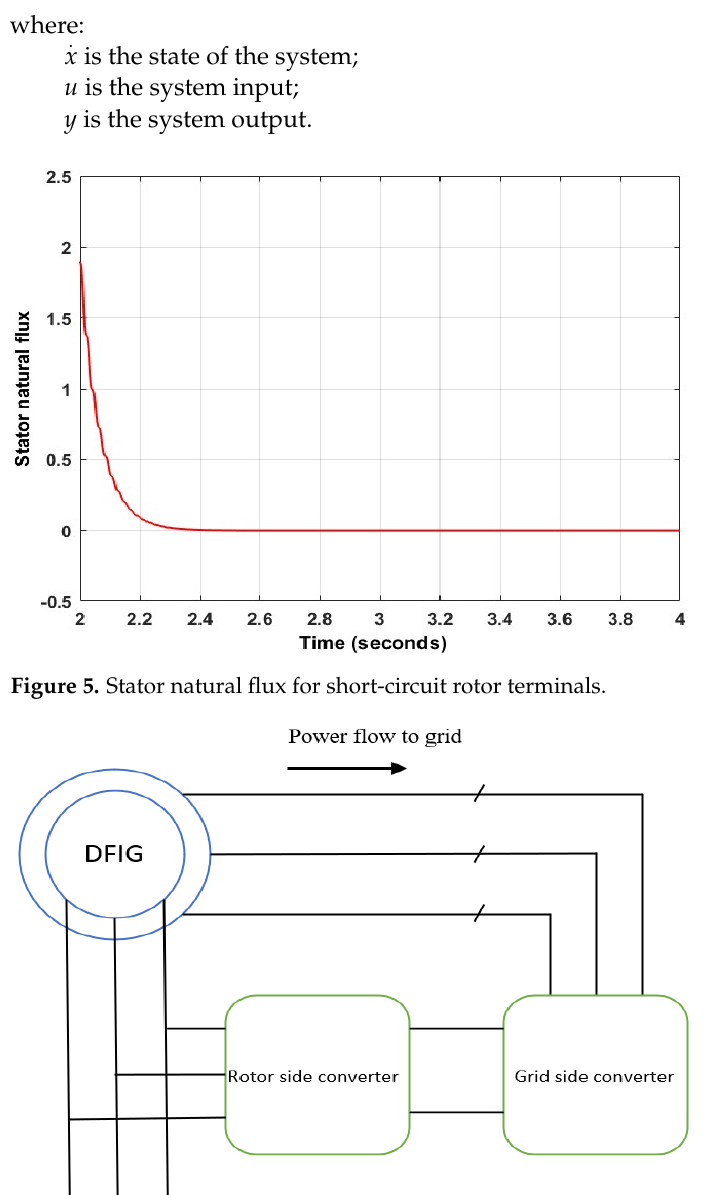
Figure 6. Topology of crowbar protection of DFIG [12].